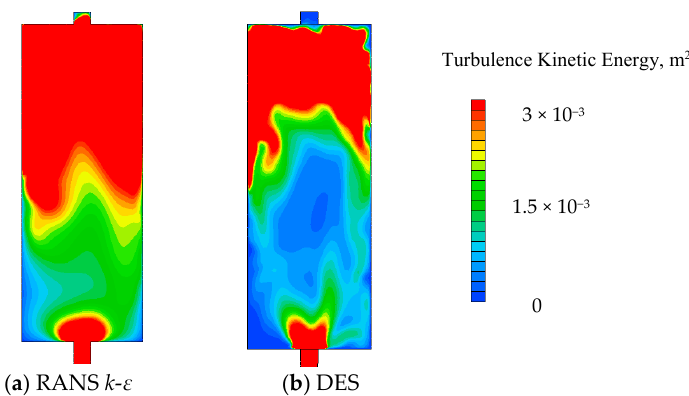
Figure 6. Comparison of turbulence kinetic energy.